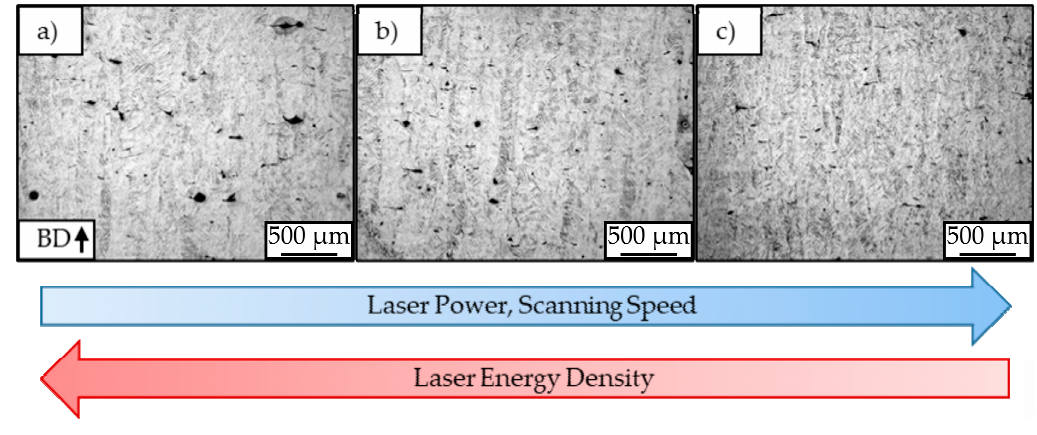
Figure 14. Microstructure for different batches A Ti ( a ), B Ti ( b ), and C Ti ( c ).